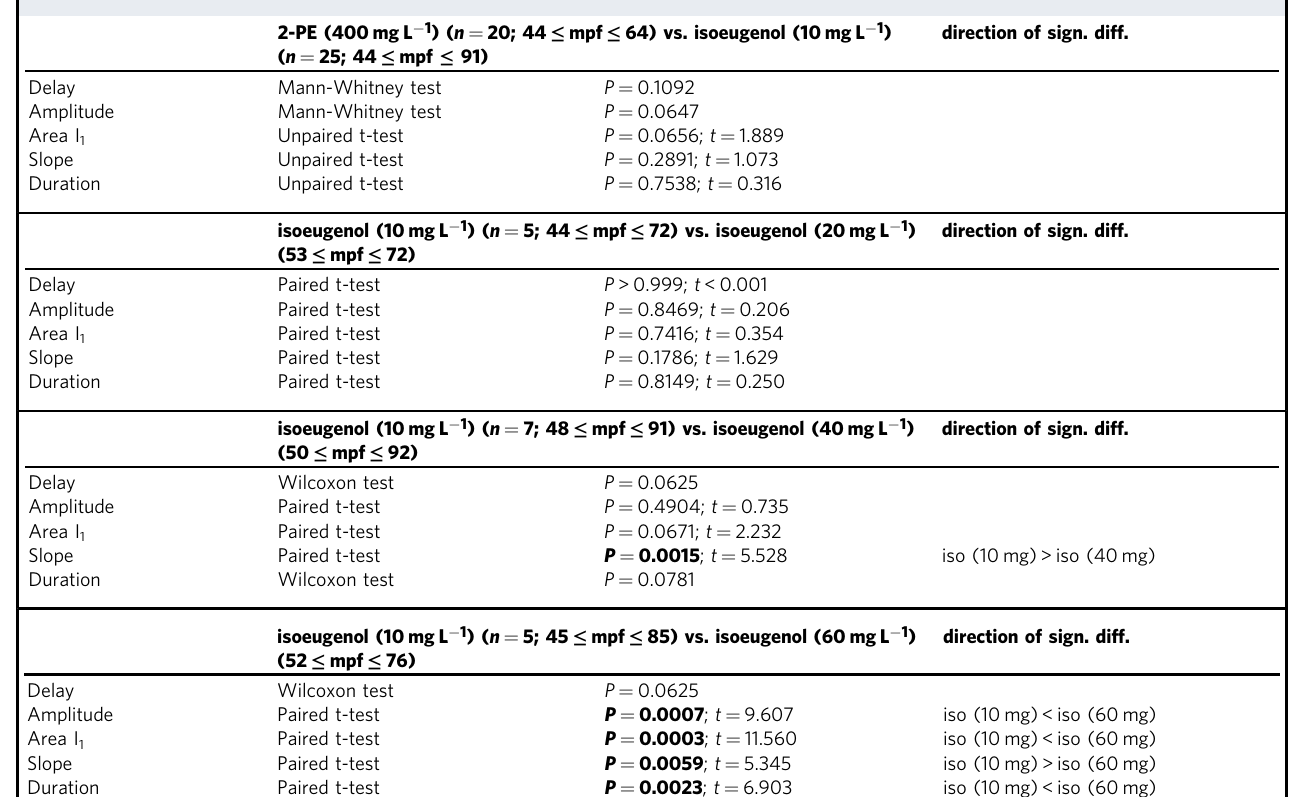
Table 1 Isoeugenol affects the action potential of the Mauthner neuron only at high concentration.